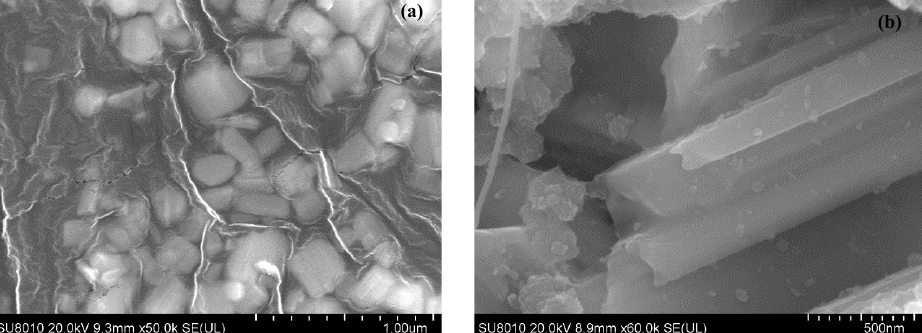
Figure 4. SEM images of ( a ) parent and ( b ) photohydrothermally treated Bi 2 WO 6 /WO 3 .